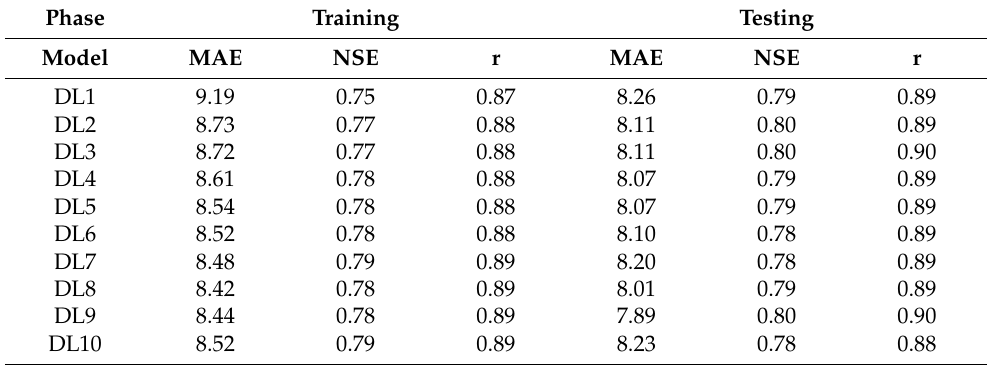
Table 5. Outcomes of the applied metrics for various DL models throughout the calibration and validation